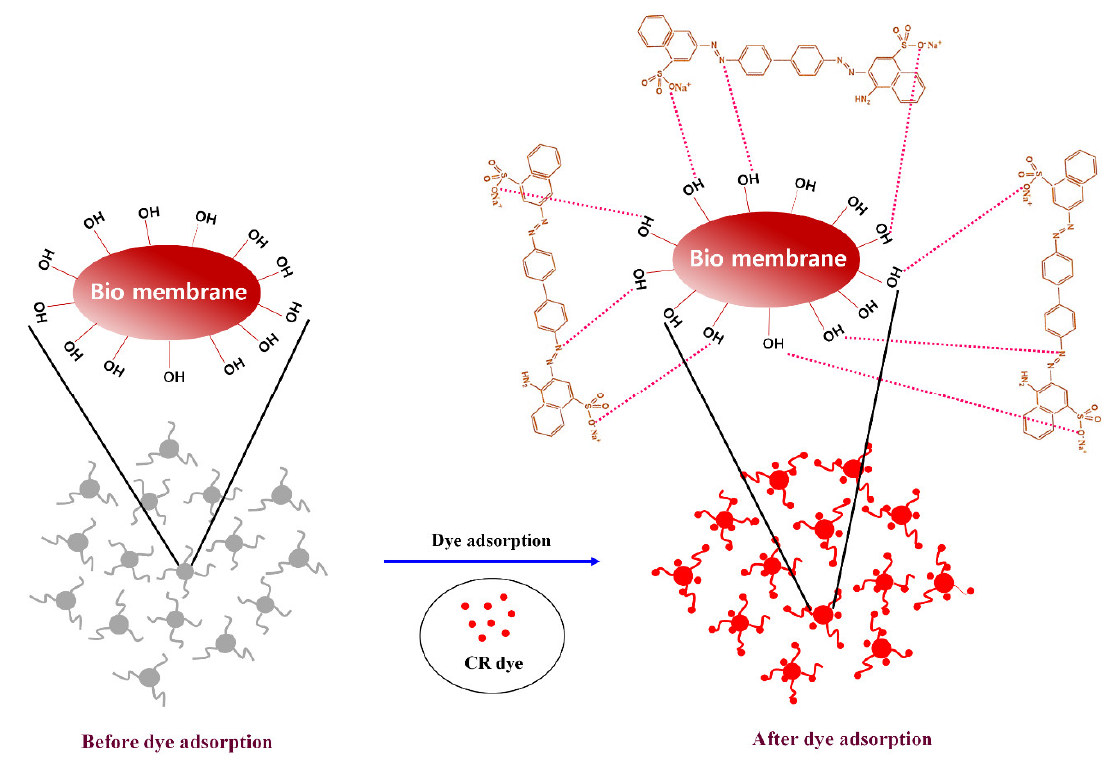
Scheme 3. CR dye molecules interact with the agar/zeolite/CMC/PVA biomembrane.